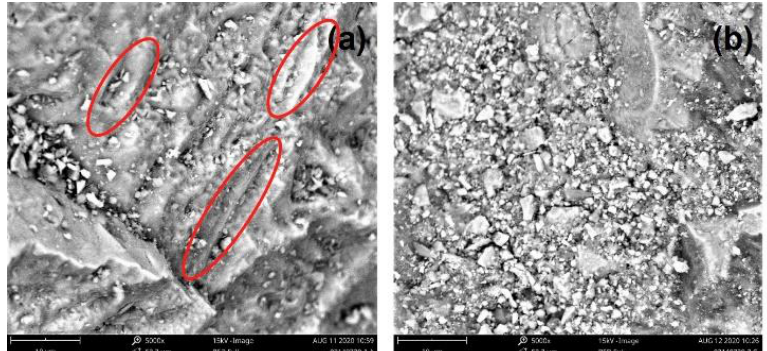
Figure 4. SEM images showing a change in the iron ore surface after dehydration: ( a ) iron ore before dehydration; ( b ) iron ore after dehydration. Red circles show needle-shaped bulges and colloform texture with cavities of goethite.